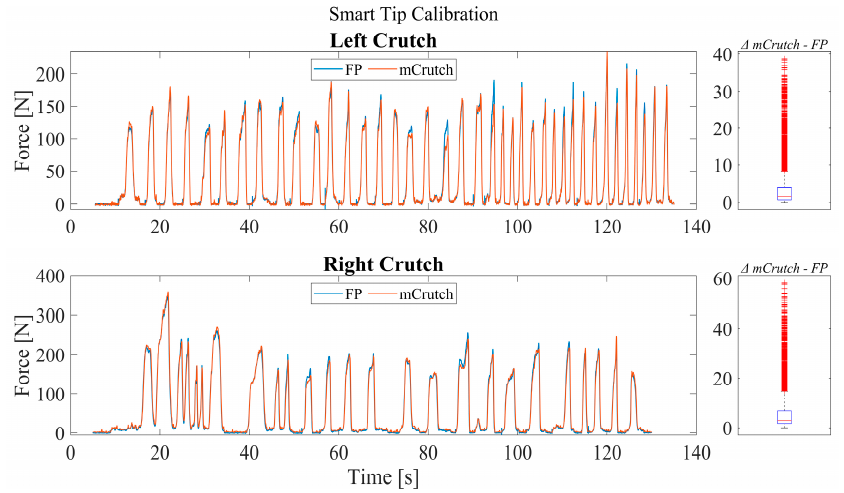
Figure 10. Smart tip calibration performance and distribution of the difference between FP and mCrutch.